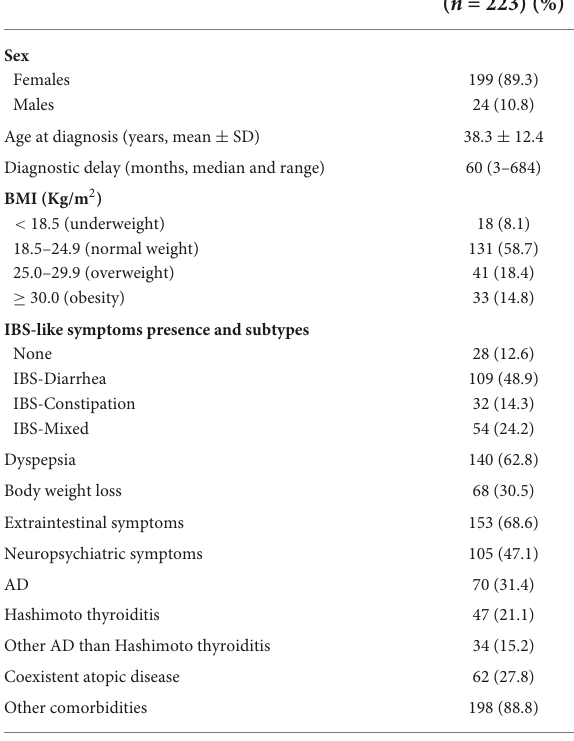
TABLE 1 Demographic and clinical features of NCWS